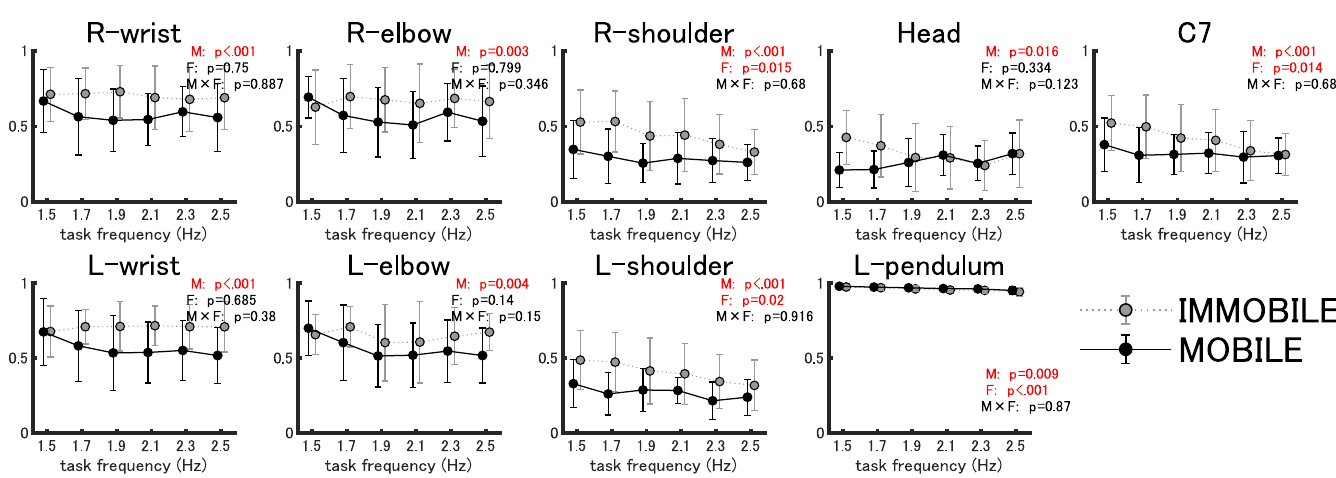
Fig 4. Motion similarity between the pendulum and body parts (in-phase) ( N =18). This shows the mean and standard deviation (error bars) of the first peak value of cross-correlation ( N =18) between the time series of the anterior-posterior motion of the pendulum and each body part by mobility (immobile vs. mobile) in gray and black dots and by frequency in the horizontal axis. Shown on the upper right of each panel is the result of the two-way analysis of variance: M is the main effect of the mobility factor, F is the main effect of the frequency factor, and M × F is the interaction of the mobility and frequency factors (p-value set at 0.05).